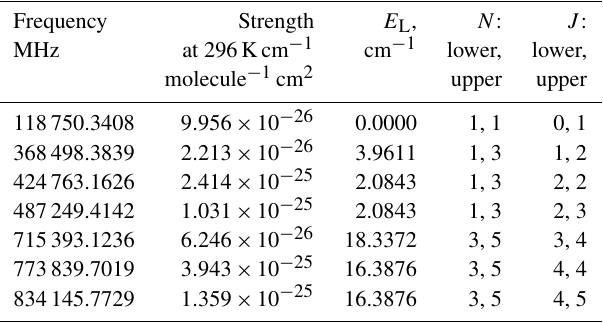
Table A1. Parameters of O 2 lines in the ground electronic and vi- brational levels between 100 and 1000GHz. Values are taken from the HITRAN